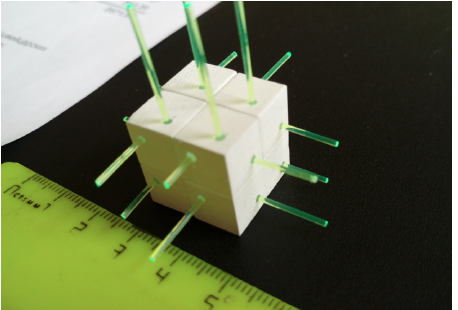
Figure 122. An assembly of 8 plastic scintillator cubes with WLS fibers. The total size of the 3DST detector is 2.53 (width)